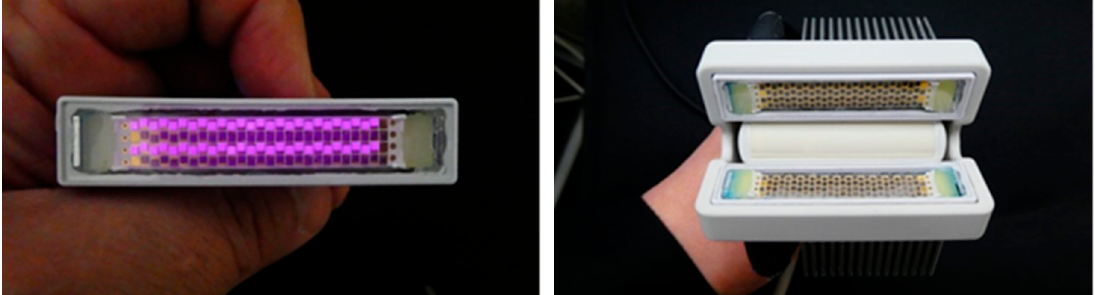
Figure 7. Photograph of an LED array developed by CYBERDYNE INC with four rows of LED elements, in which Rows 1 and 3 are 850 nm elements, and Rows 2 and 4 are 750 nm elements ( left ). In this picture, the 850 nm elements are activated and captured using an IR camera. Photograph of a LED-based PA / US probe developed by CYBERDYNE INC, in which two LED arrays (750 / 850 nm) are placed on both sides of a linear array US probe (7 MHz) ( right